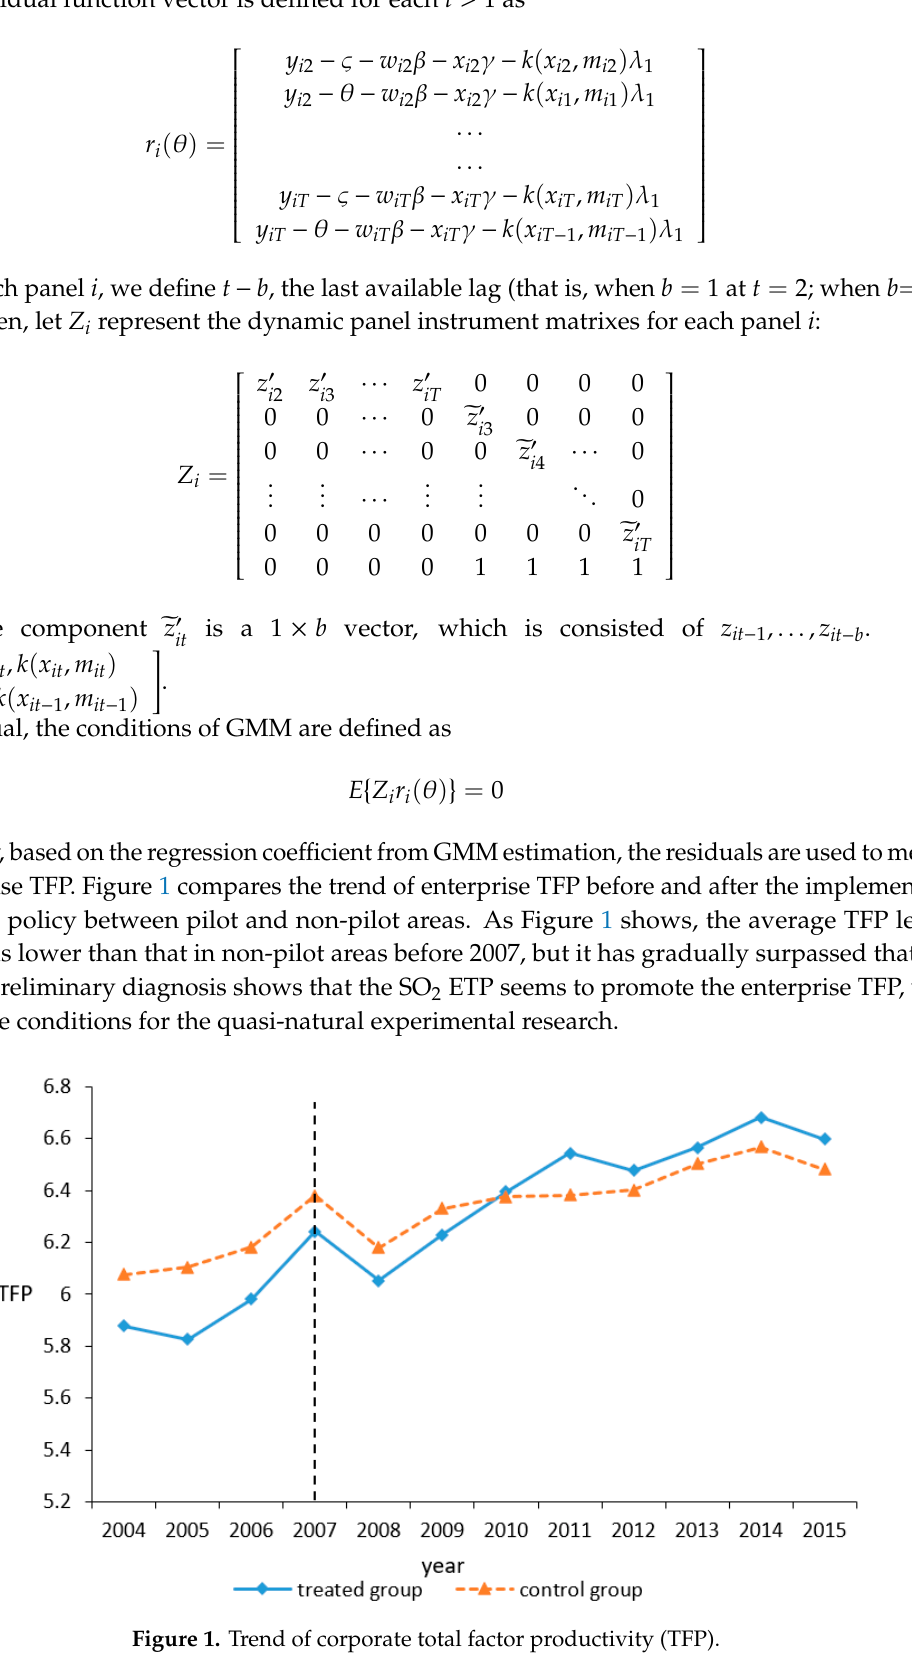
Figure 1. Trend of corporate total factor productivity (TFP).